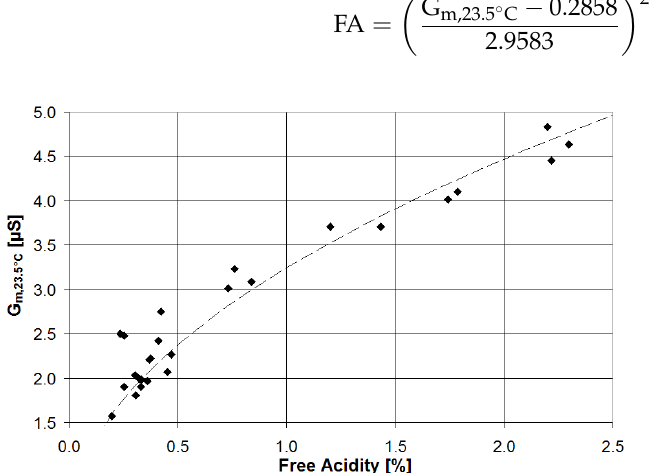
Figure 3. Scatter plot of the emulsion electrical conductance measured at 23.5 °C using the HAS reagent vs. free acidity for the subset of olive oil samples featuring a peroxide index < 20 meq O 2 /kg oil.